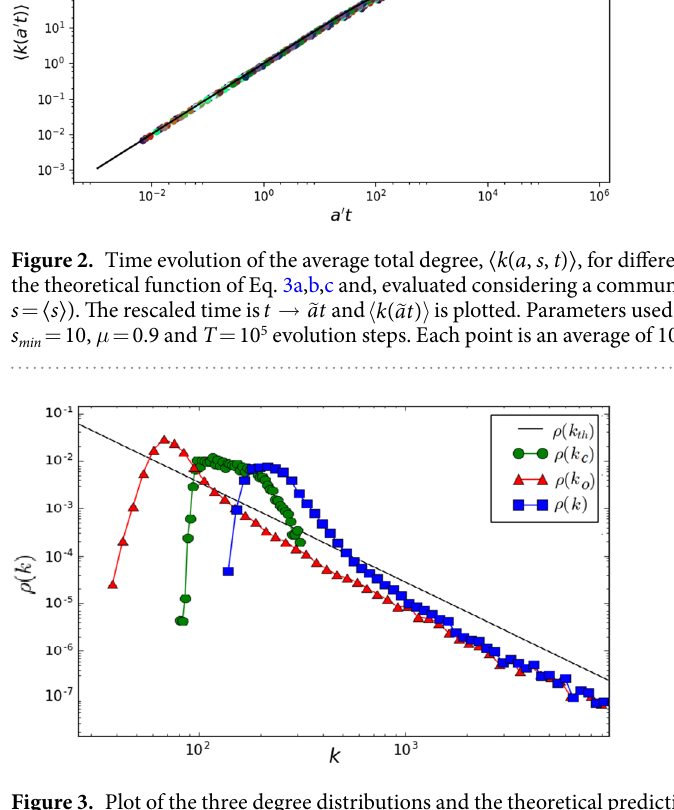
Figure 3. Plot of the three degree distributions and the theoretical prediction, given in Eq. 4. Parameters used are: N = 10 5 , ω = 2.1, ν = 2.1, s min = 10, μ = 0.9 and T = 10 5 evolution